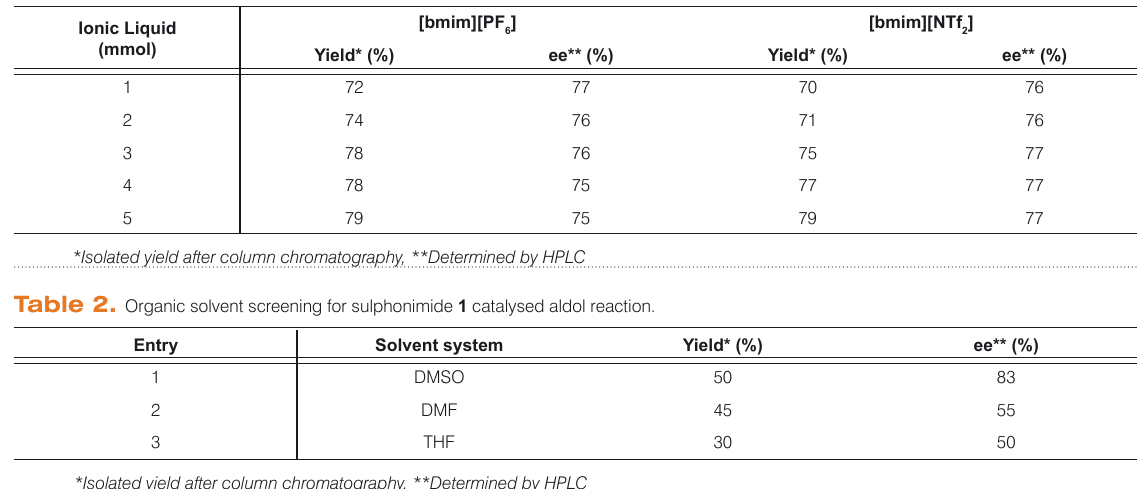
Table 1. Ionic liquid optimization for sulphonimide 1 catalysed aldol reaction.